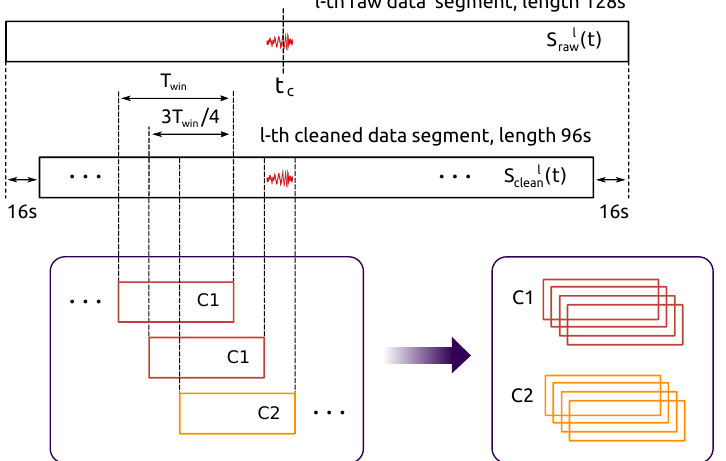
Figure 3. Strain samples generation by slidding windows. A CBC GW injection is located at coalescence time t c in l th raw strain data segment of 128 s. After a cleaning, the segment is splitted − in overlapped windows, individually identifying whether a window has or does not have the GW injection. Finally, among all these windows, , and discarding C 1 windows with SNR < 10, a set of eight strain samples is selected, four with noise alone ( C 1) and four with noise plus the mentioned CBC GW injection ( C 2). This set of eight samples will be part of the input dataset of our CNNs. This procedure is applied to all raw strain data